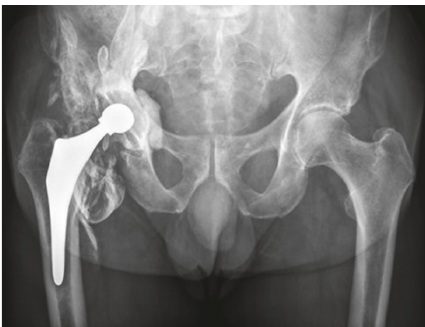
Figure 3: AP radiograph, one year postoperative. Periarticular densities around all components with flattening of the femoral